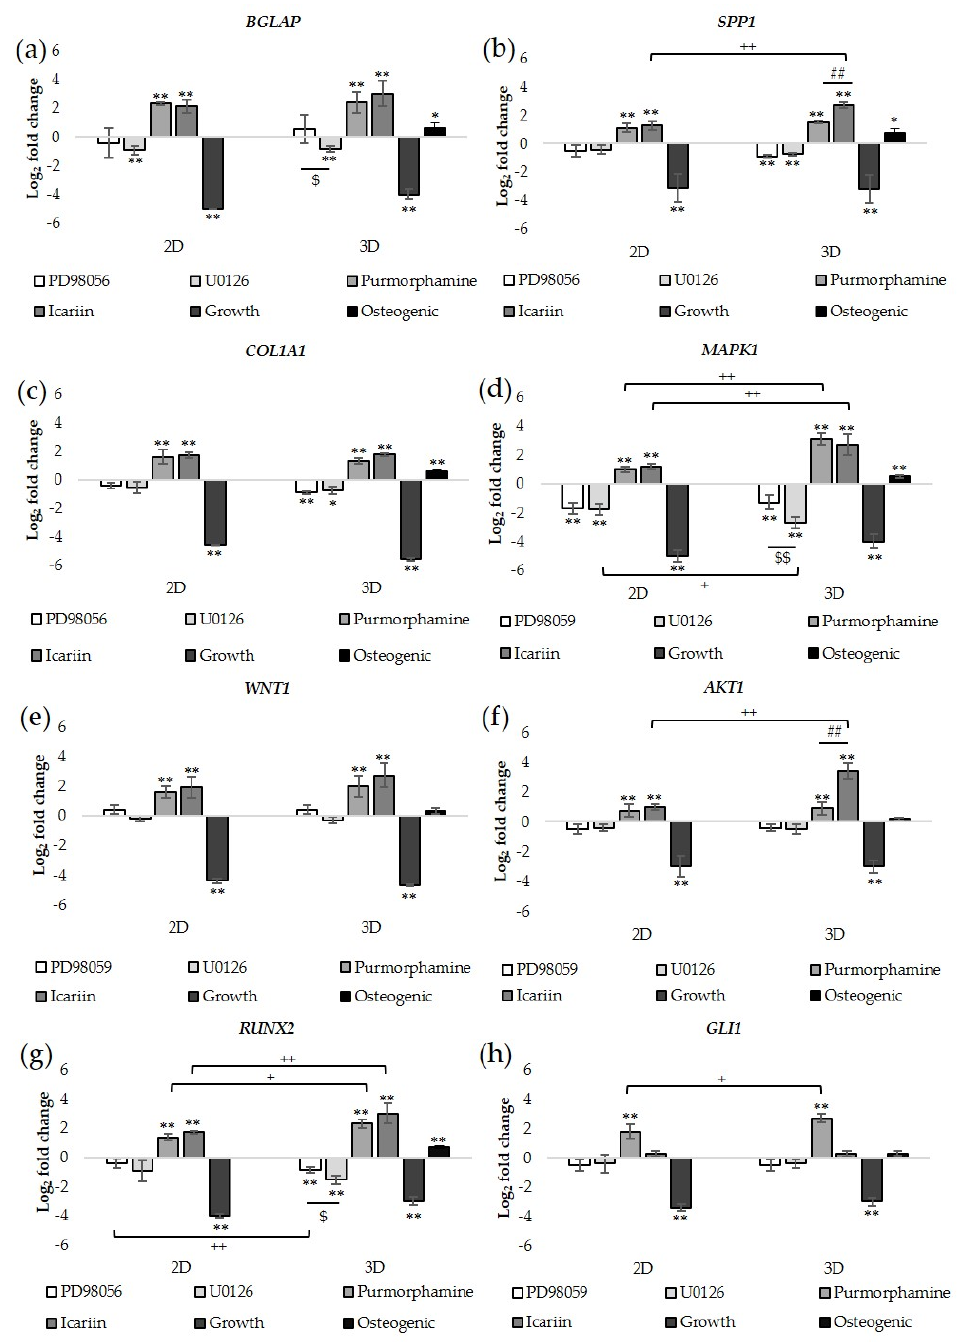
Figure 4. For treated and untreated bioprinted constructs (3D) and monolayer cultures (2D), RT-qPCR was used to determine the expression of osteogenesis associated genes ( a ) BGLAP , ( b ) SPP1 , ( c ) COL1A1 , ( d ) MAPK1 , ( e ) WNT1 , ( f ) AKT1 , ( g ) RUNX2 , and ( h ) GLI1 after four weeks of culture. The graph shows the log 2 fold changes in gene expression relative to the osteogenic medium control grown in 2D culture conditions. Indicated error bars represent the standard deviation, and significance was determined by one-way ANOVA with Tukey’s multiple comparison test. * p < 0.05 compared to osteogenic medium control in 2D culture conditions, ** p < 0.01 compared to osteogenic medium control in 2D culture conditions, + p < 0.05 between 3D constructs and 2D monolayer cultures, ++ p < 0.01 between 3D constructs and 2D monolayer cultures, ## p < 0.01 between Icariin and Purmorphamine 3D constructs, $ p < 0.05 between U0126 and PD98059 treated 3D constructs, and $$ p < 0.01 between U0126 and PD98059 treated 3D constructs. n = 3 for each